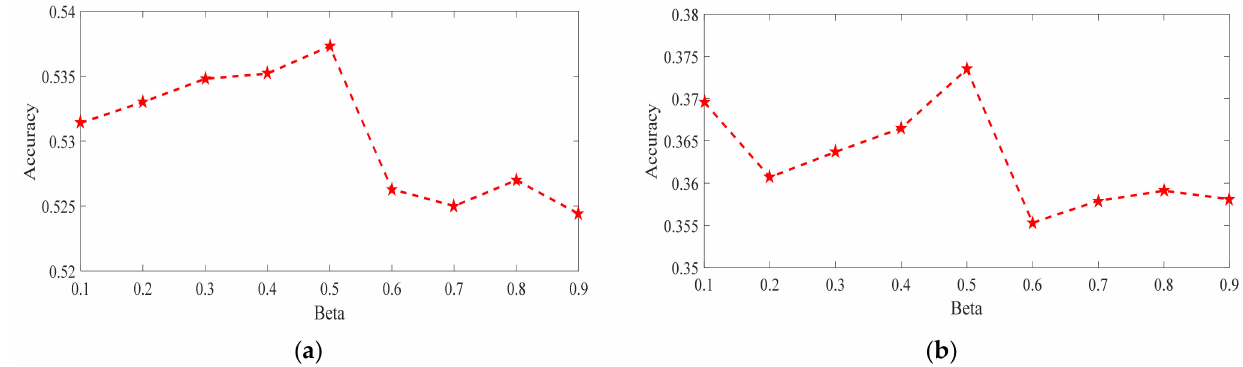
Figure 3. Parameter sensitivity on the two datasets. ( a ) Sensitivity on MovieLens; ( b ) sensitivity on